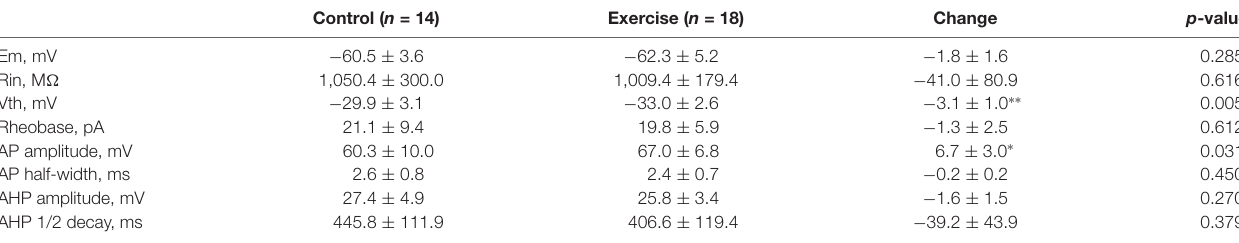
TABLE 1 | Exercise effects on membrane properties of Serotonin (5-HT) neurons.